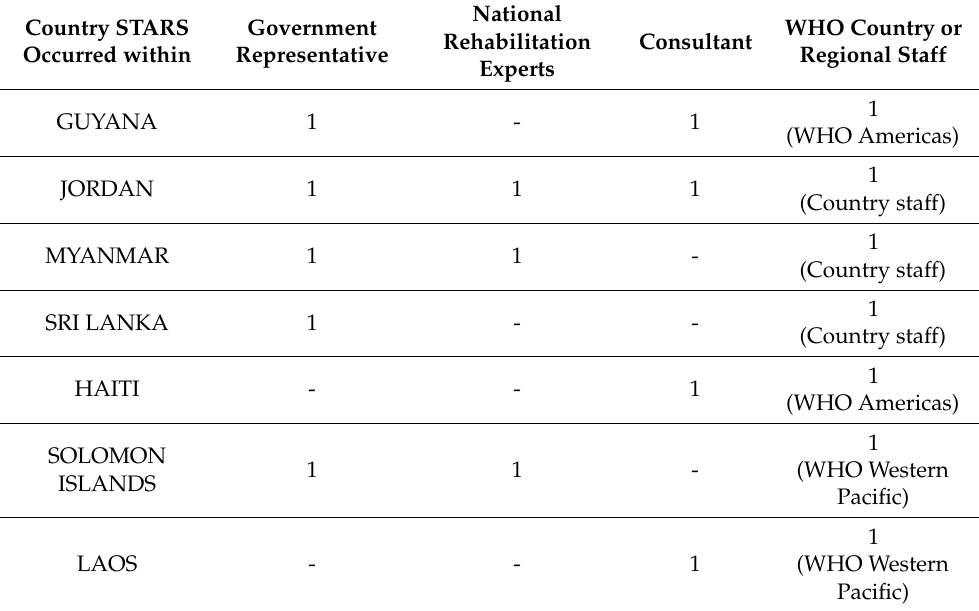
Table 2. Composition of Interviewees.